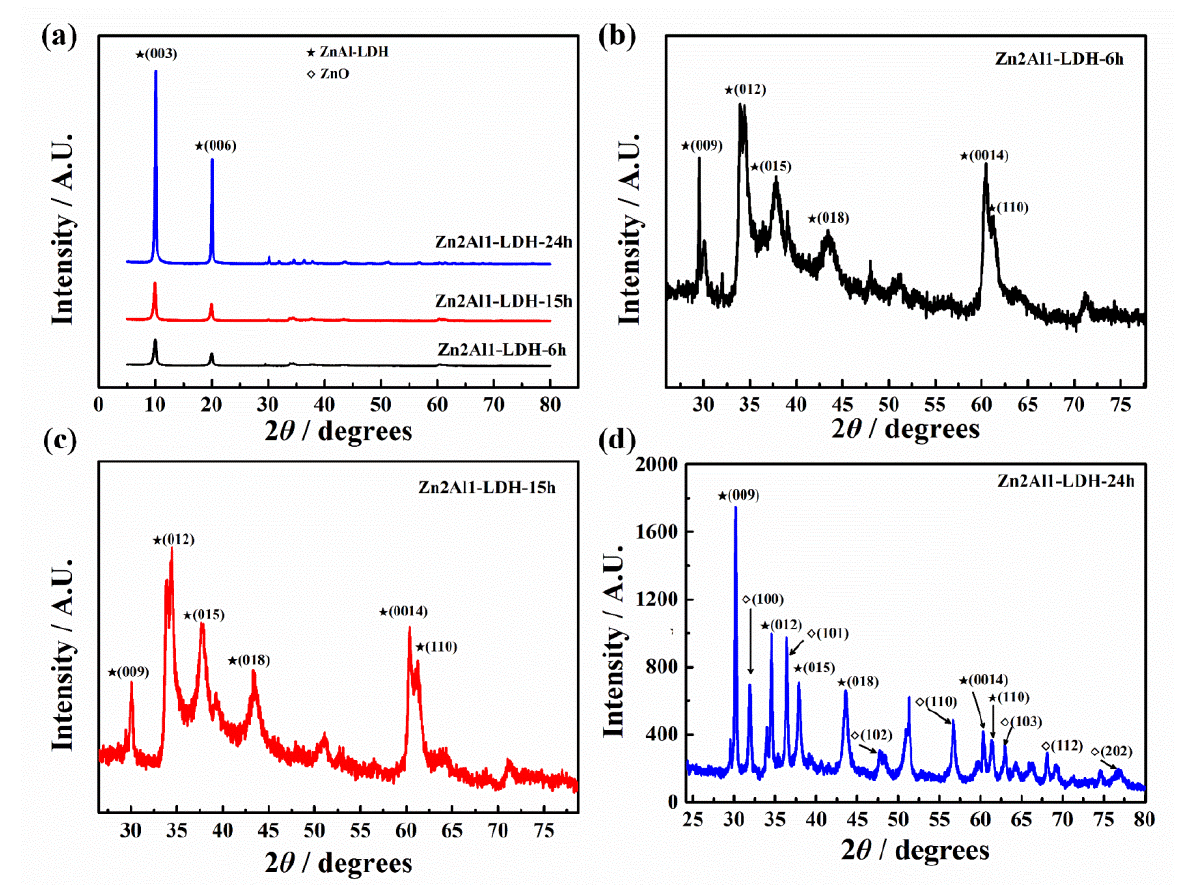
Figure 6. The XRD spectrum of ( a ) ZnAl-LDH synthesized at different hydrothermal time; ( b ) Zn2Al1-LDH-6h from 24 to 80°; ( c ) Zn2Al1-LDH-15h from 24 to 80°; ( d ) Zn2Al1-LDH-24h from 24 to 80°.